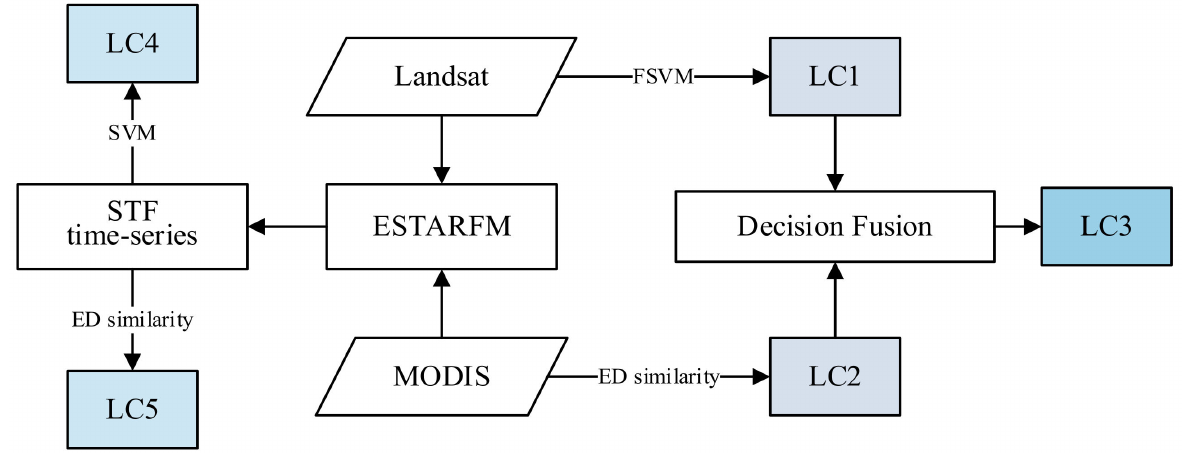
Figure 4. Workflow of the comparison experiment in two